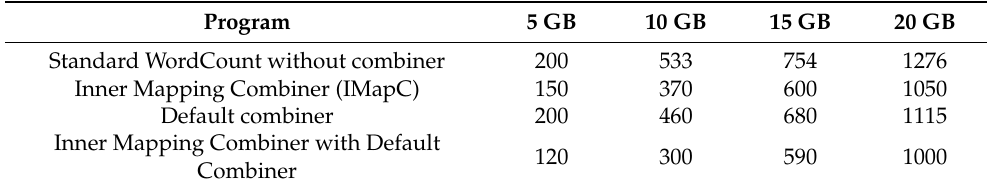
Table 2. Performance improvement of IMapC with Default Combiner on running WordCount program in Standard Hadoop.